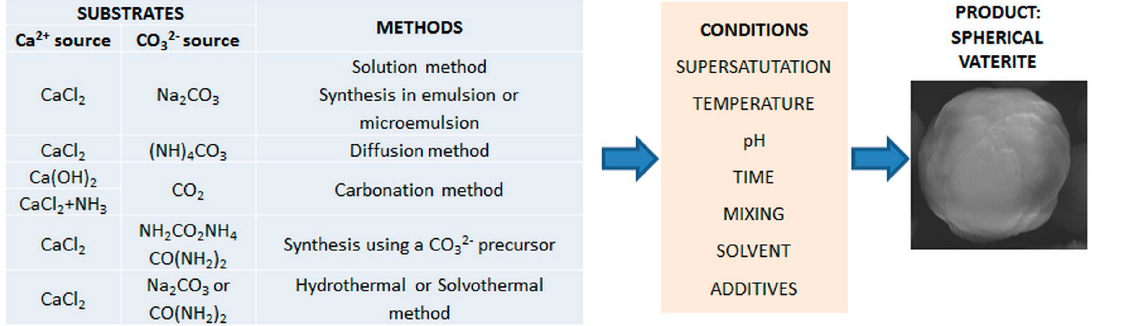
Figure 1. Diagrammatic representation of raised issues.